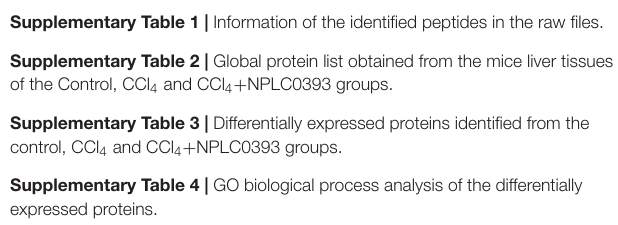
Supplementary Figure | Evaluation of sample and data quality. Supplementary Table 1 | Information of the identified peptides in the raw files. Supplementary Table 2 | Global protein list obtained from the mice liver tissues of the Control, CCl 4 and CCl 4 + NPLC0393 groups. Supplementary Table 3 | Differentially expressed proteins identified from the control, CCl 4 and CCl 4 + NPLC0393 groups. Supplementary Table 4 | GO biological process analysis of the differentially expressed